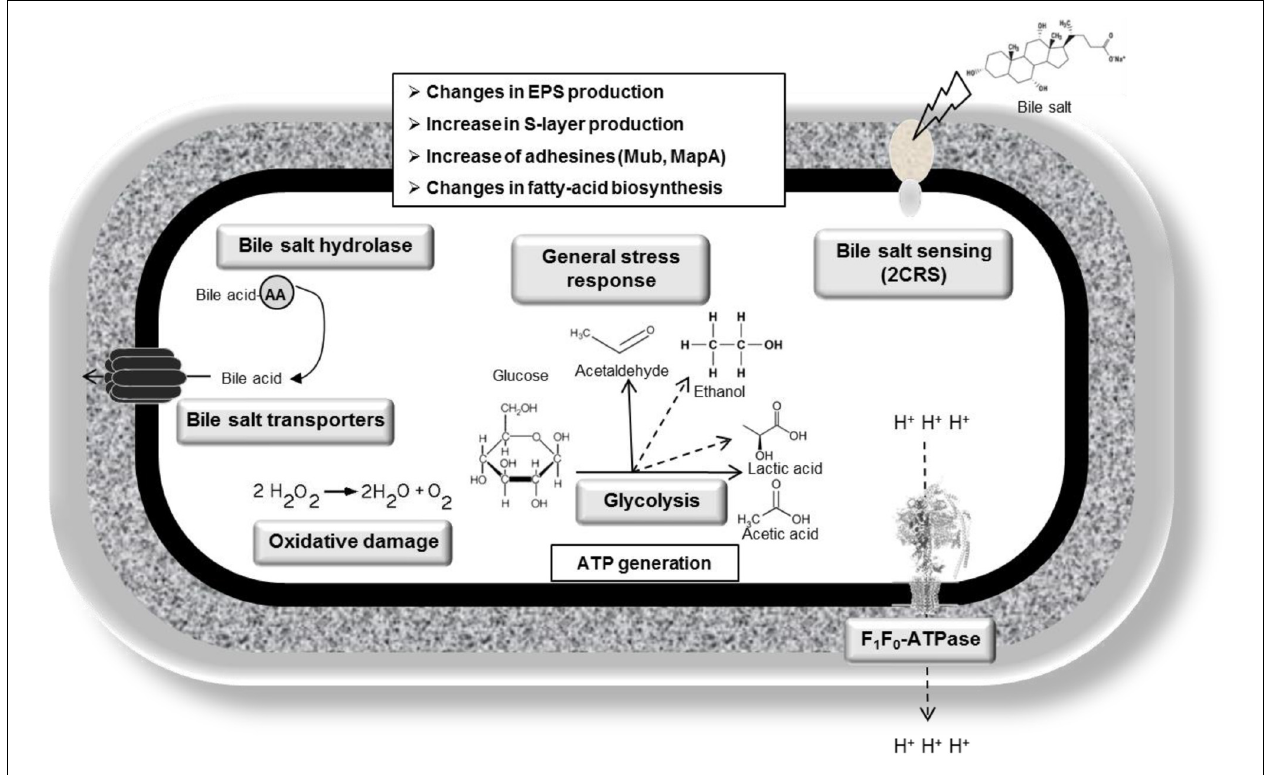
FIGURE 1 | Bile response mechanisms identified and characterized in